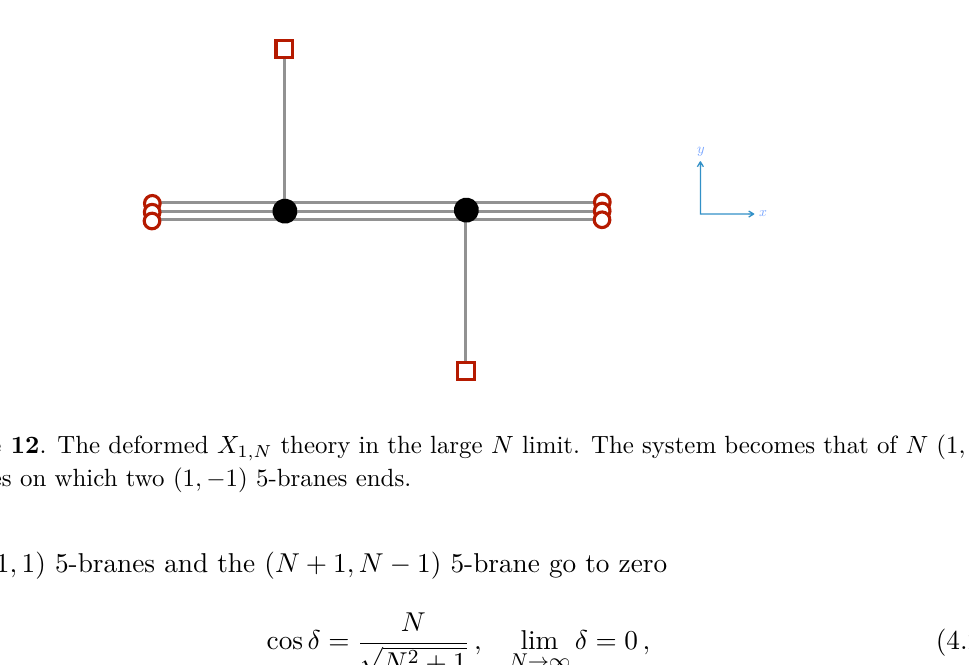
Figure 11 . The two competing brane webs after the supersymmetry breaking deformation. The recombined system consists of one (1 , − 1) 5-brane and N (1 , 1) 5-branes, separated in a direction transverse to the ( x, y ) plane.